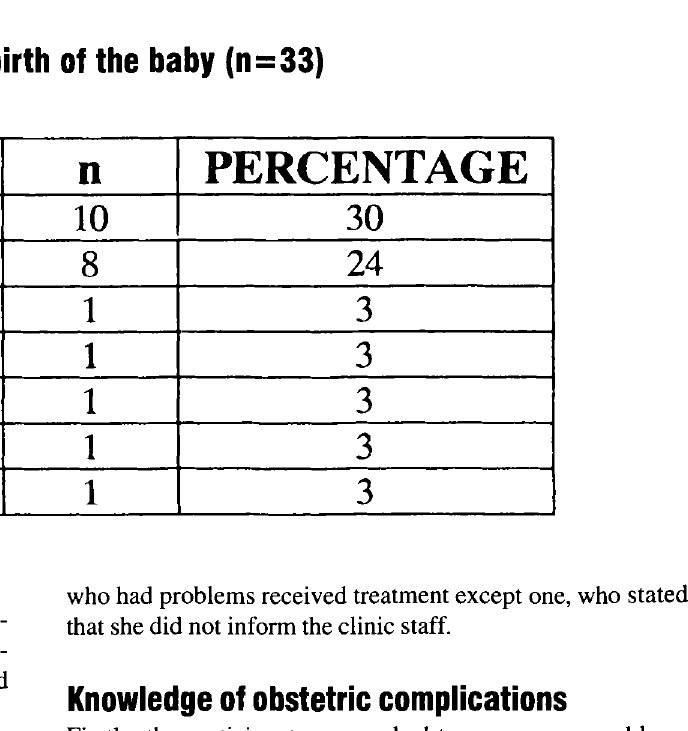
Table 4: Problems that may occur after the birth of the baby